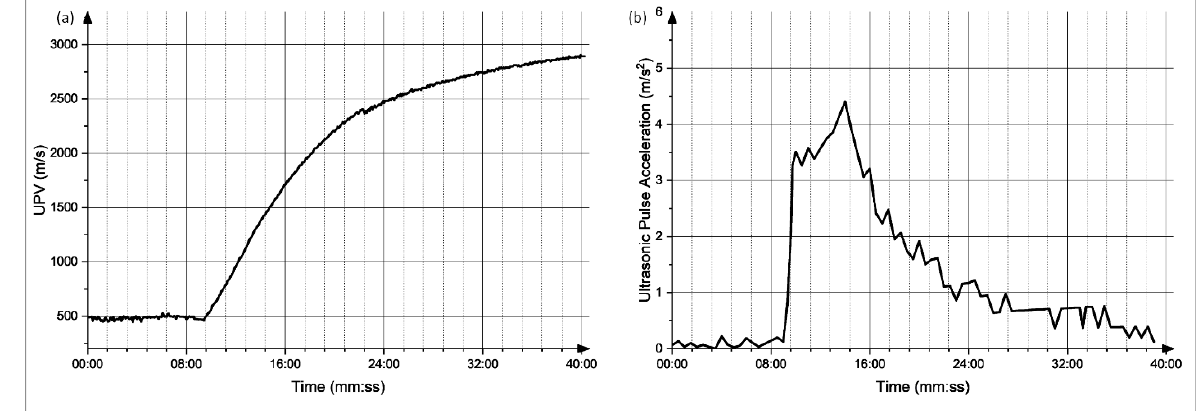
Figure 10. ( a ) Evolution of UPV with time for mix 2. ( b ) Derivative of the UPV graph.